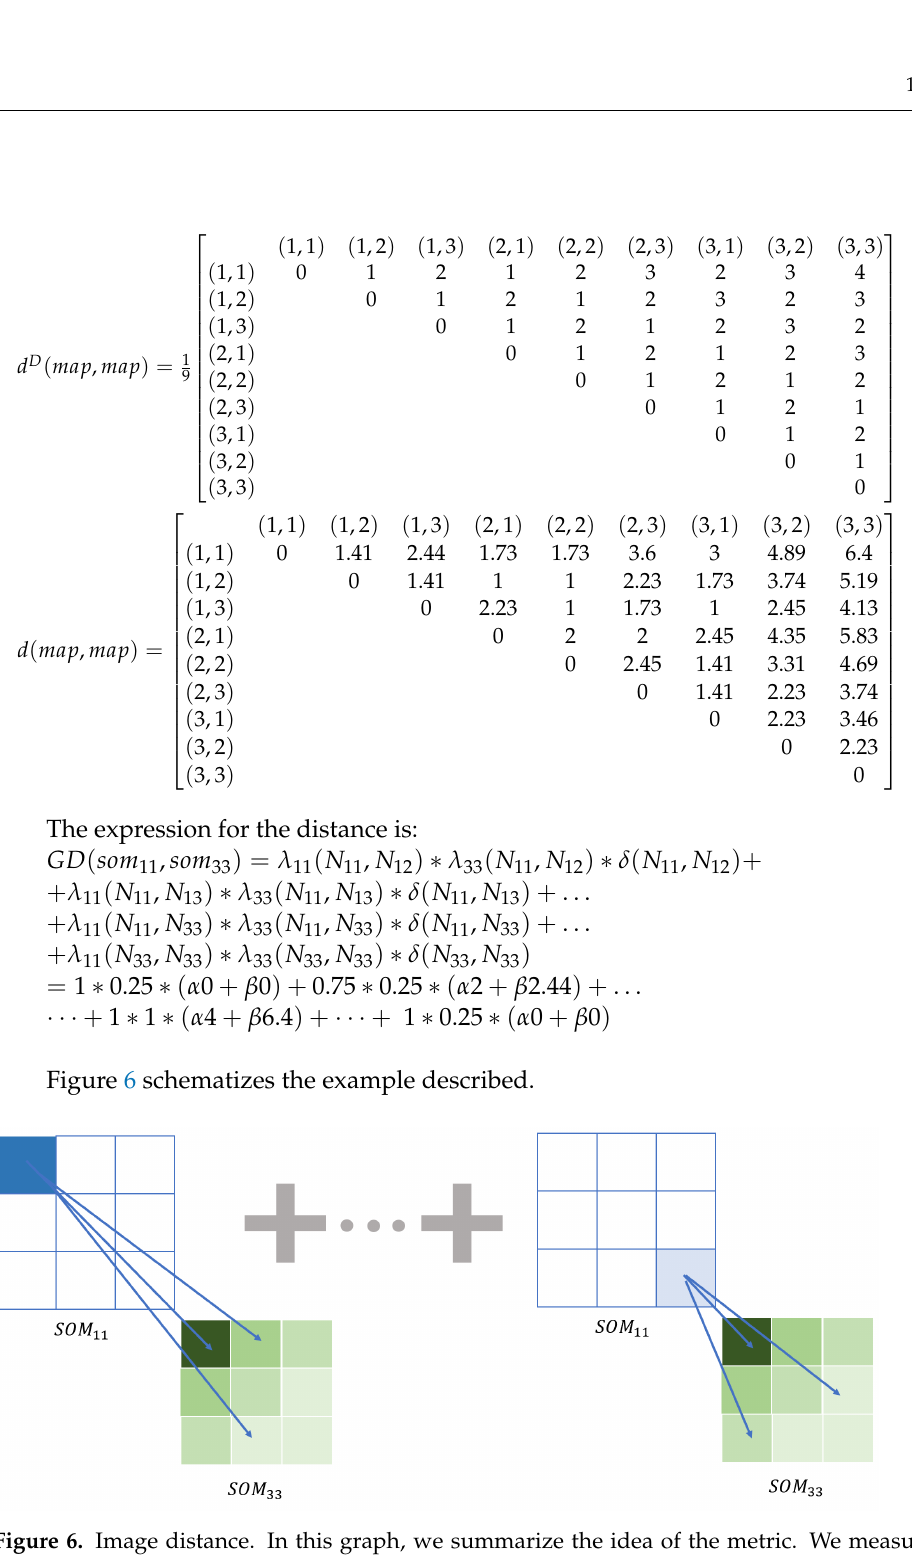
Figure 6. Image distance. In this graph, we summarize the idea of the metric. We measure the distance between the maps associated with each point. It will generally be the same map except for the winning node and its neighborhood. Here, we can observe that when comparing the winning node N11 of the SOM11 map (node in intense blue) with the nodes of the SOM33 map whose winning node is 33, we have to take this spatial relationship into account. The gradient of the colors represents the reduction of the effect of the distance between these nodes in the global distance, which is calculated with the lambda